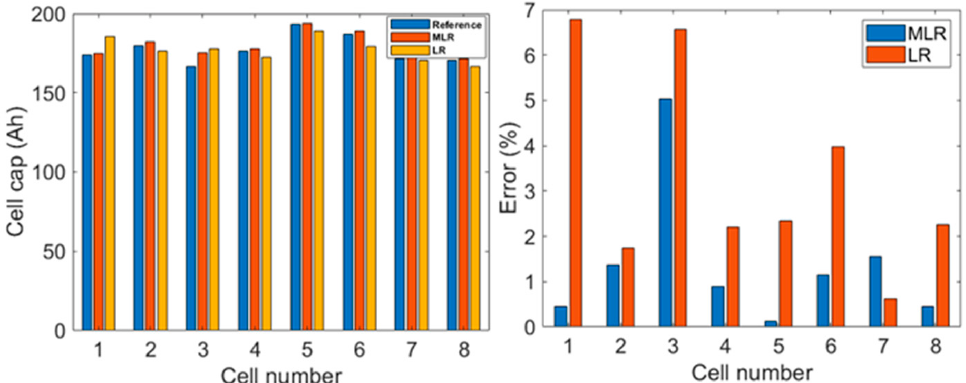
Figure 11. Estimation results and estimation error with data-driven method (interface data).